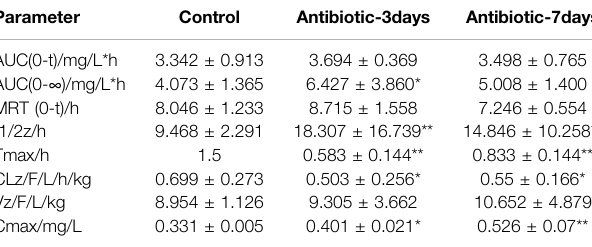
TABLE4| ComparisonofthepharmacokineticparametersofRivaroxaban(n=3).